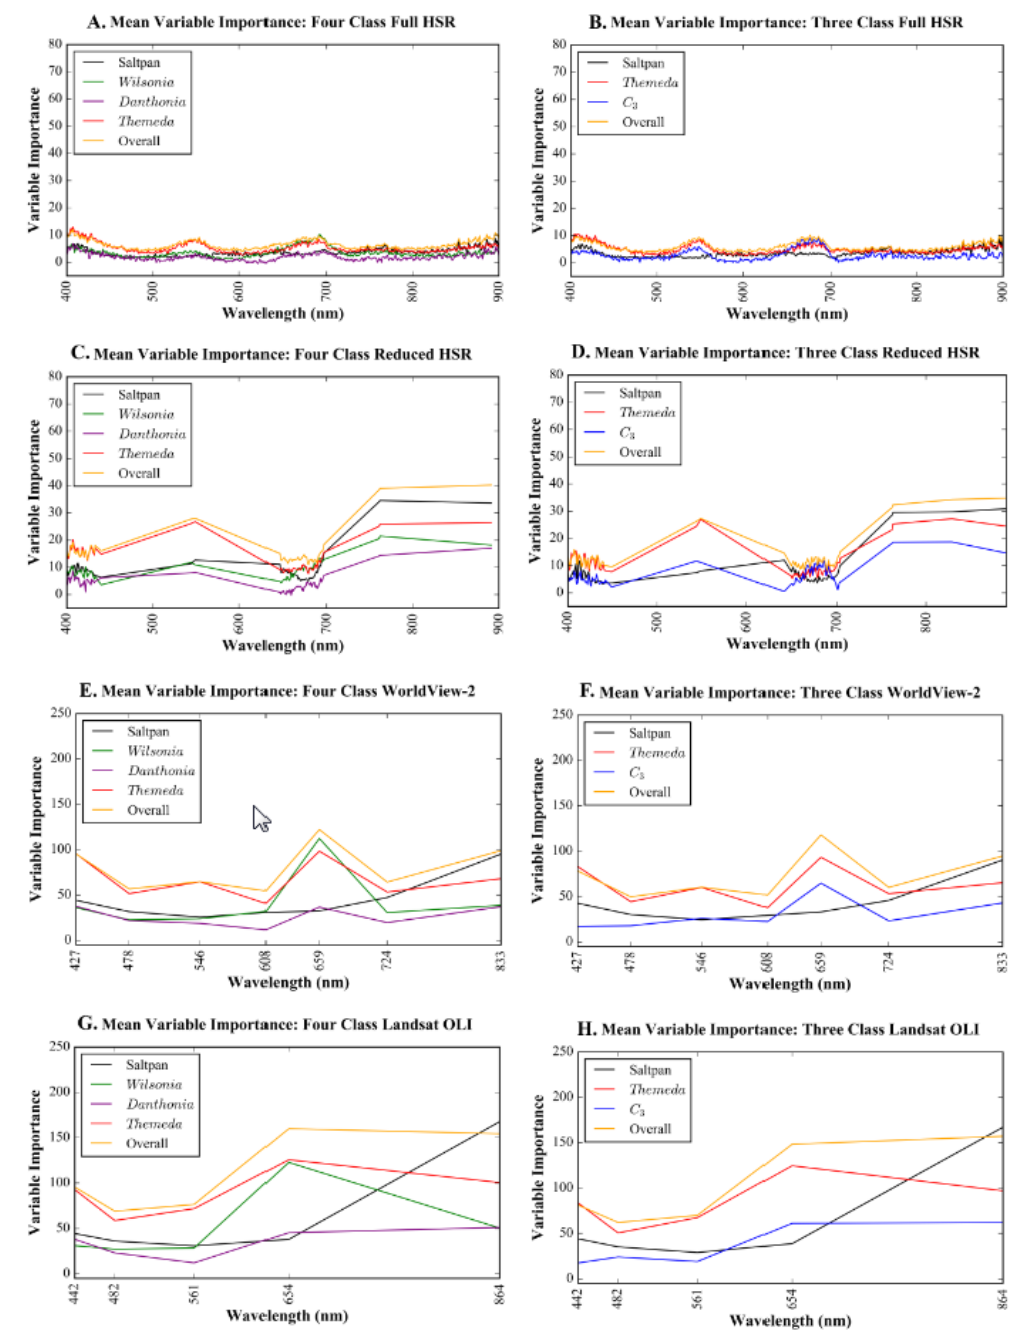
Figure 4. Subfigures ( A ) to ( H ) show the mean RF variable importance for all class configurations across the test datasets. Importance values are reported for each band as an average value across the 30 RF models produced. Higher plot values mean that for the given class, the variable is more important in the classification.